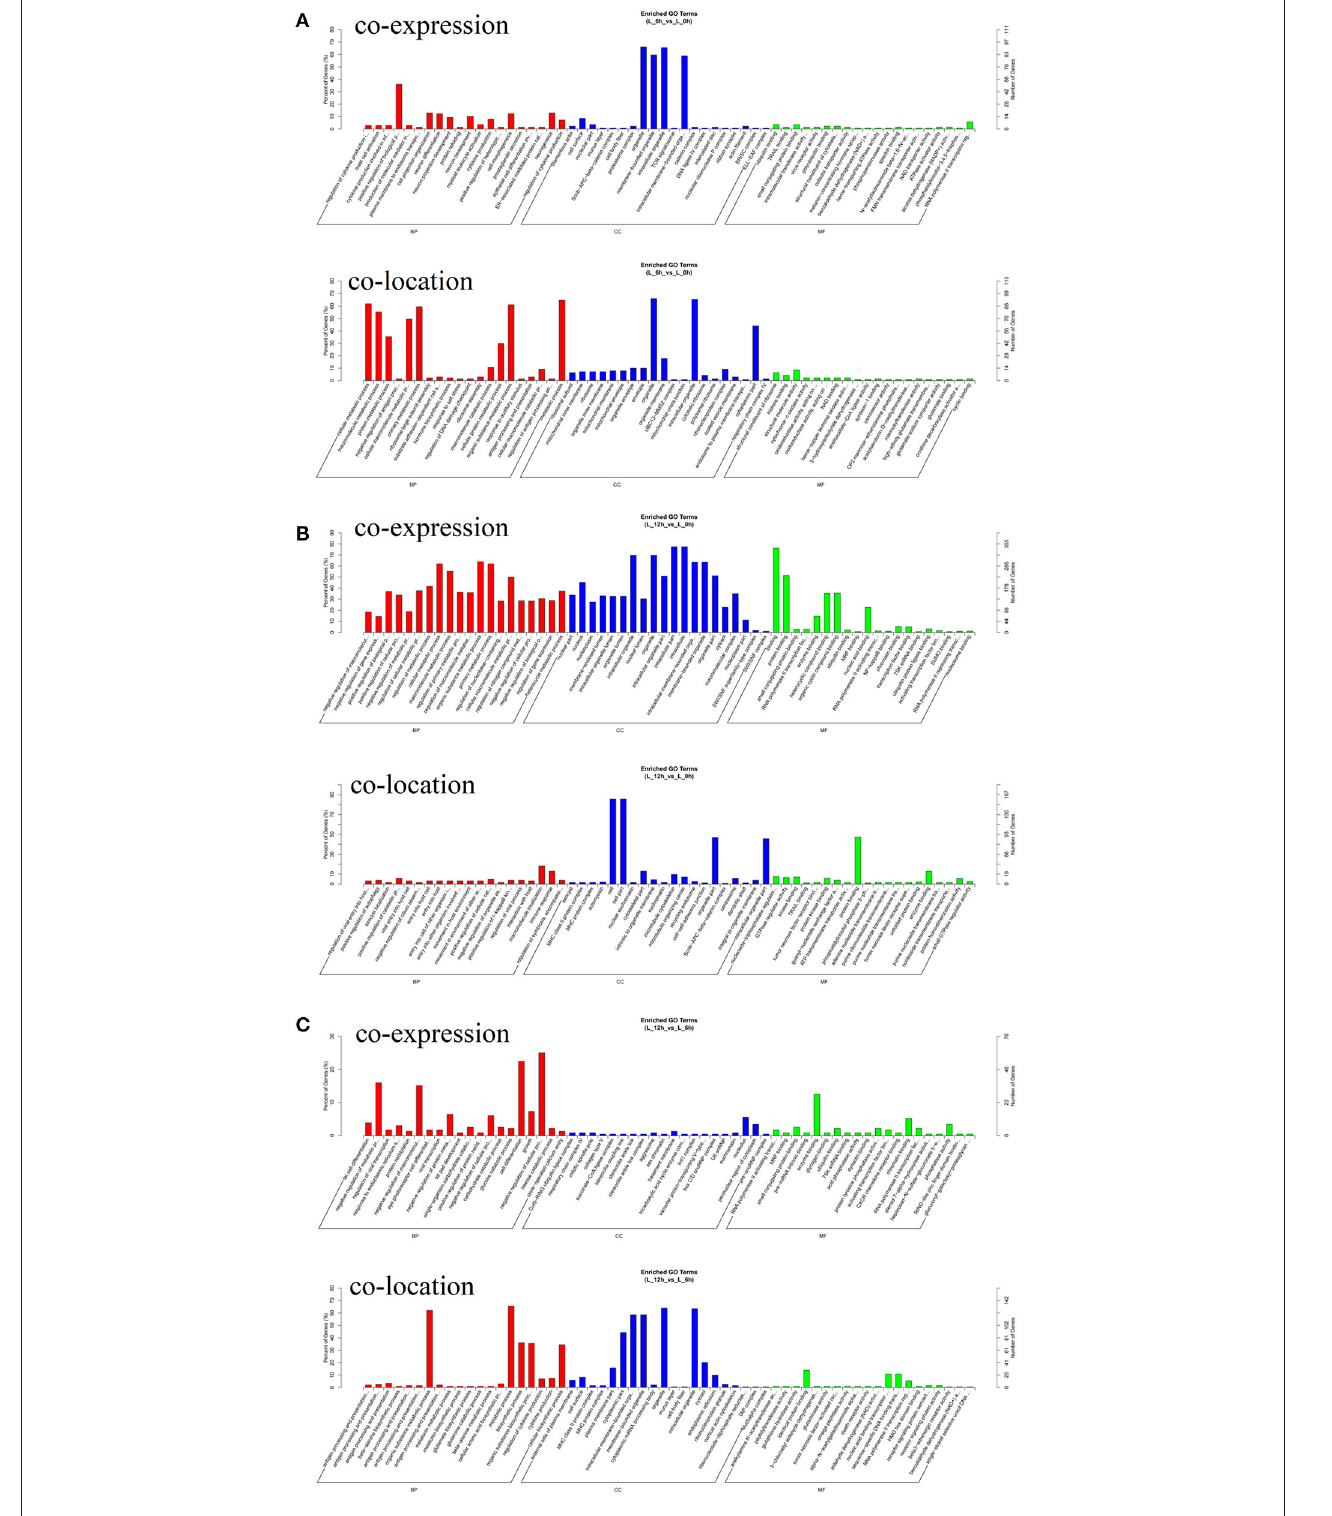
FIGURE 6 | GO enrichment analysis of target genes for DElncRNA. (A) Functional enrichment analysis of DElncRNAs at 6 hpi compared to 0h. (B) Functional enrichment analysis of DElncRNAs at 12 hpi compared to 0h. (C) Functional enrichment analysis of DElncRNAs at 12 hpi compared to 6 hpi.